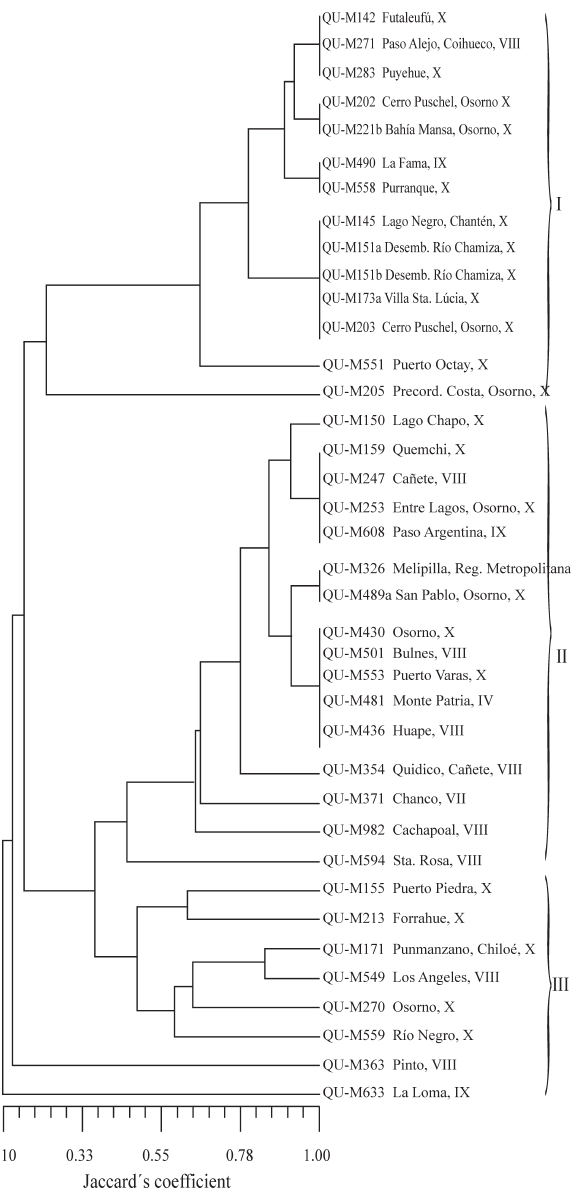
Figure 2 - Dendrogram based on simple sequences repeat (SSR) analysis of 39 Chilean isolates of Metarhizium anisopliae var.